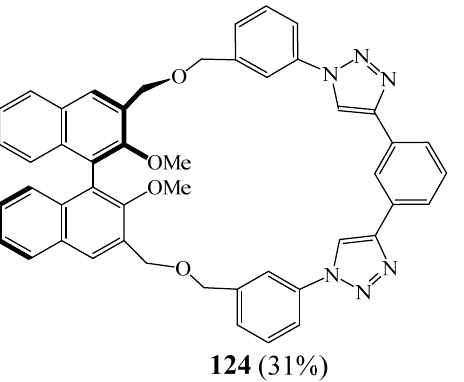
Figure 30. Structures of bitriazolic macrocycles 124. (Reprinted with permission from ref. [50]. Copyright 2012 Elsevier)